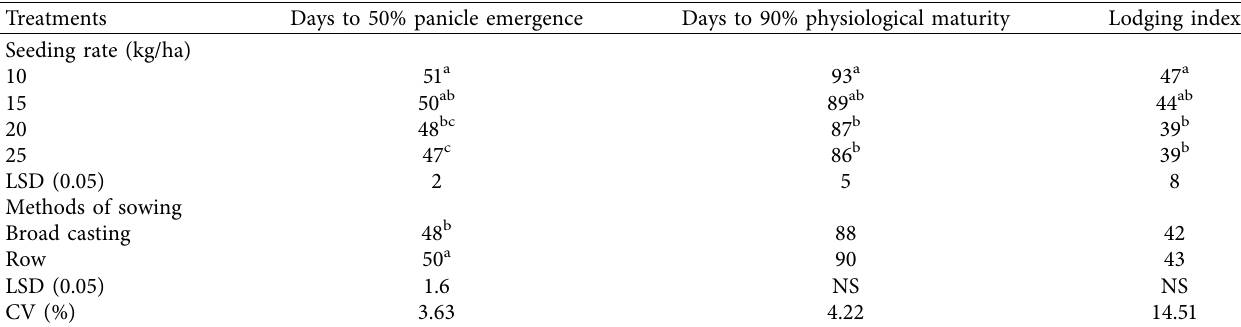
Table 1: Main effect of the seeding rate and methods of sowing on days to 50% panicle emergence, days to 90% physiological maturity, and lodging index of teff crop.